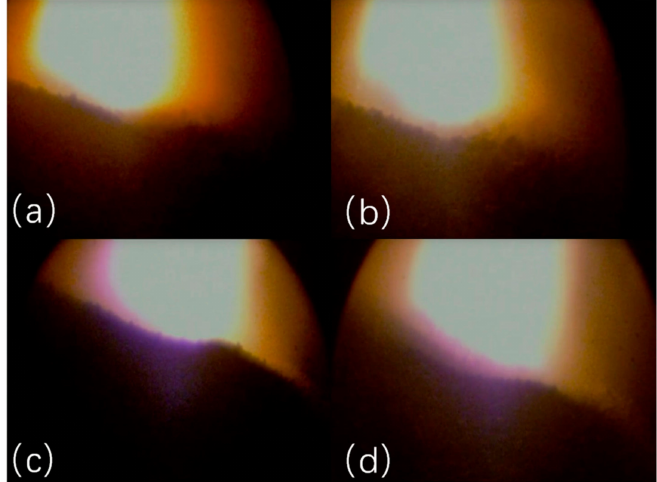
Figure 9. Bad Burden surface images captured using the industrial endoscope. ( a ) Unclear texture image. ( b ) Low edge strength image. ( c ) Low image brightness image. ( d ) Low signal-to-noise ratio image.